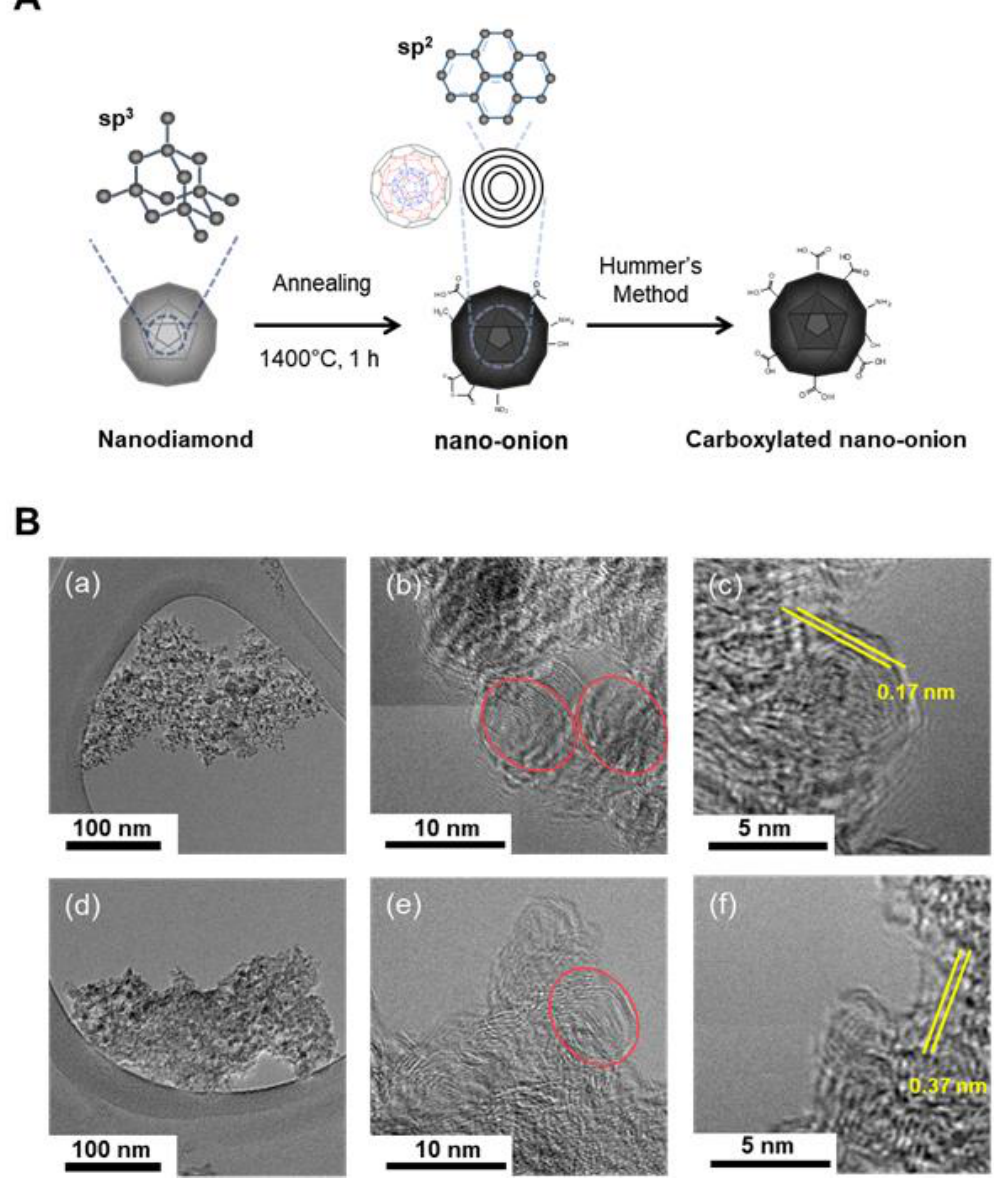
Figure 1. ( A ) Schematic drawing of structural changes from nanodiamond into carbon nano-onion particles (CNO) by pyrolysis and into CNO–COOH by Hummers’ method; ( B (a–c)) Transmission electron microscopy (TEM) images of CNO, and ( B (d–f)) CNO–COOH. The crystalline lattice gap of the onion-like layer is present in both CNO (B(c)) and CNO–COOH (B(f)), yellow bars showing the gap between lattices.